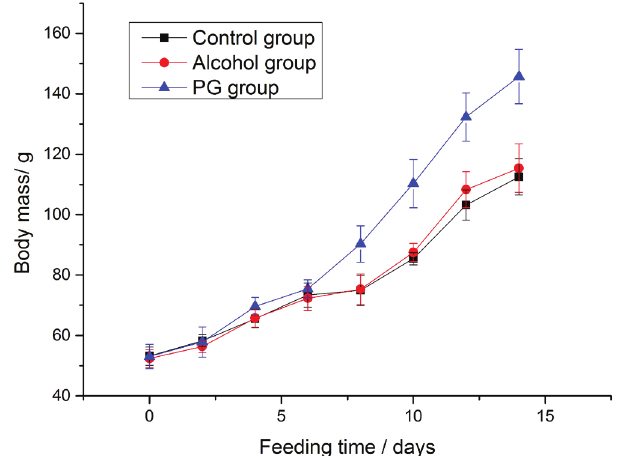
FIGURE 1 - Effect of PG on the body mass.